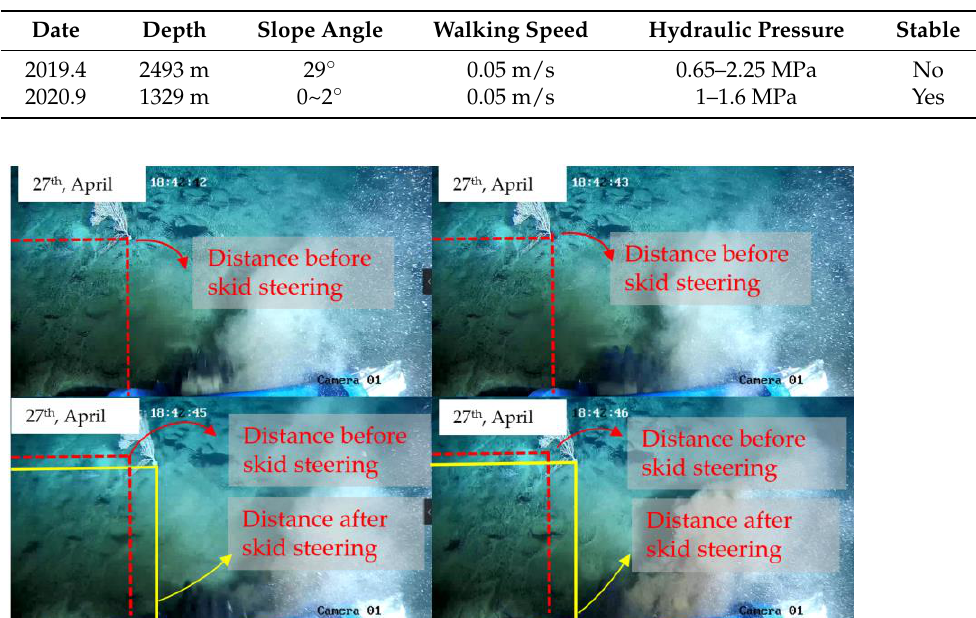
( b ) Figure 21. Grooves after crushing. ( a ) 2019 Sea trial (From vehicle), ( b ) 2020 Sea trial ( From Manned Submersible). Many parameters can affect the vehicle ’ s stability during sea trials. First, the slope angle decreases the vehicle’s vertical contact force on the slope and decreases the vehicle’s resistance and anti-skid friction torque, and decreases the stability at last. Second, the sub- strate and crusts of the first mining place have more high strength than the second place. W e can find out by the cylinder’s pressure during cutting . The first test achieved more significant normal resistance which will also decrease the vehicle’s vertical contact force on the slope. The rough surface will affect the vehicle ’ s pitch and roll while walking, but the influence will decrease when the vehicle begins to cut, as shown in Figure 16. The roll change is due to the rough seafloor before 60 s, and the vehicle cuts during walking after 60 s. The roll is mostly stable, and there are some changes due to the rough surface. There- fore, the strength of the substrate, crusts, and slope angle significantly impact the mining vehicle ’ s stability and need to be fully investigated before business mining. The mining site’s microtopography may affect the vehicle’s pitch and roll and needs to be investi- gated, too. 6. Conclusions The authors proposed a modeling method for estimating the performance of the min- ing vehicle based on the mining vehicle ’ slope stability, anti-slip stability, and anti-skid steering stability condition. The model adopted the dimensionless parameters of the min- ing vehicle ’ s structure. The influence of the mining vehicles under different slope angles,